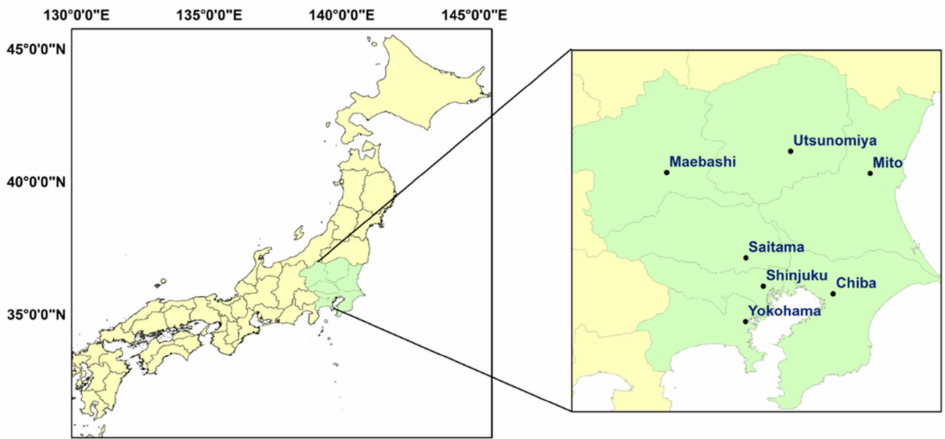
Figure 1. Location of Kanto in Japan and the seven evaluated points.